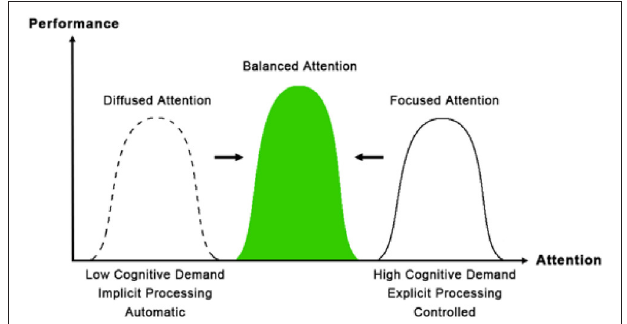
FIGURE 1 | Attention, effort, and optimal performance. Balanced attention improves performance in both high effort, explicit processing tasks and low-effort, implicit processing